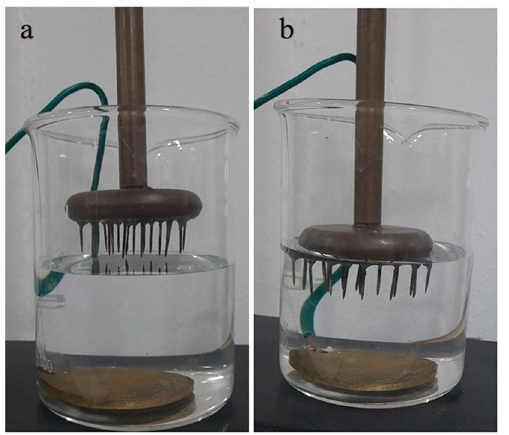
Figure 3. Static water treatment with multiple pin HV electrode to plane ground electrode in ( a ) α -configuration and ( b ) β -configuration.